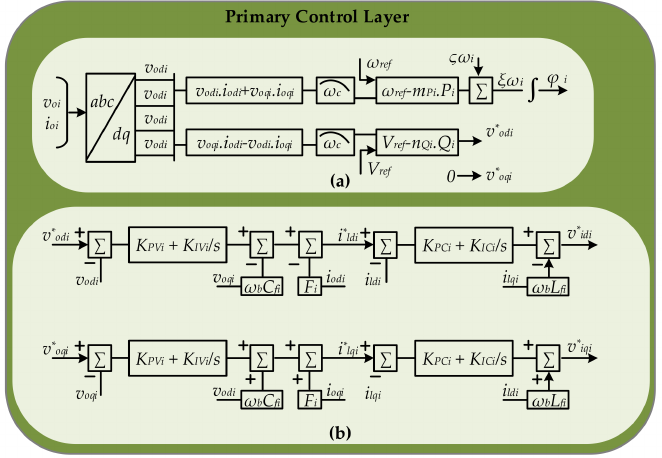
Figure 2. ( a ) Power controller of ith inverter ( b ) inner voltage and current control